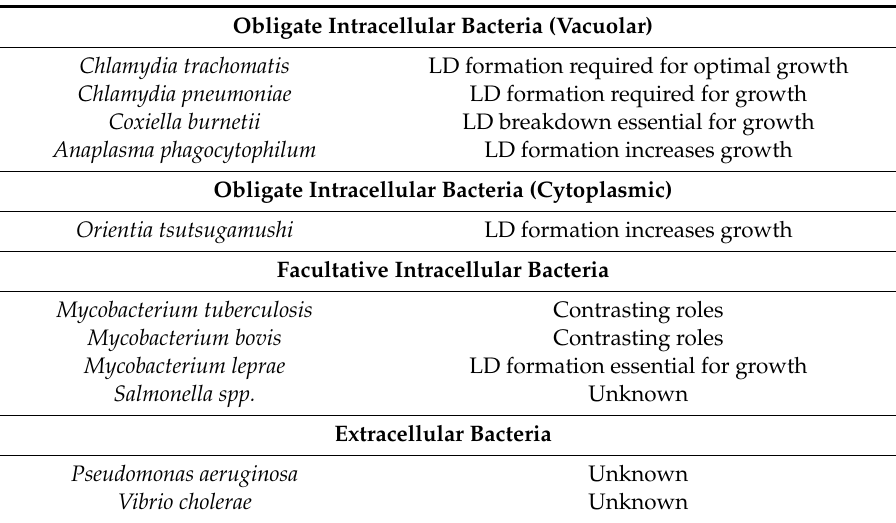
Table 1. E ff ect of lipid droplets (LDs) on bacterial